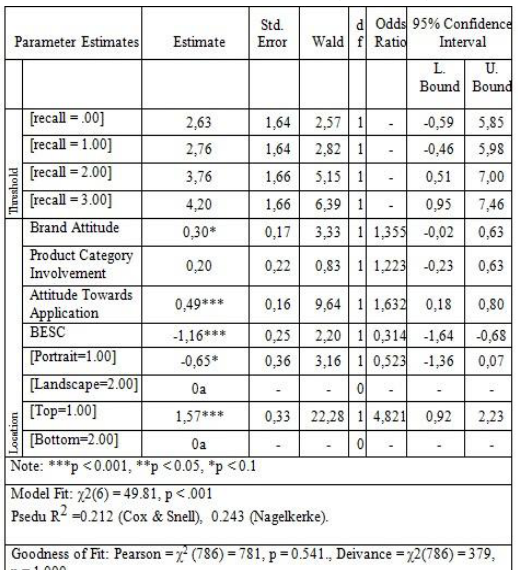
Table 3: Results of Ordinal Logistic